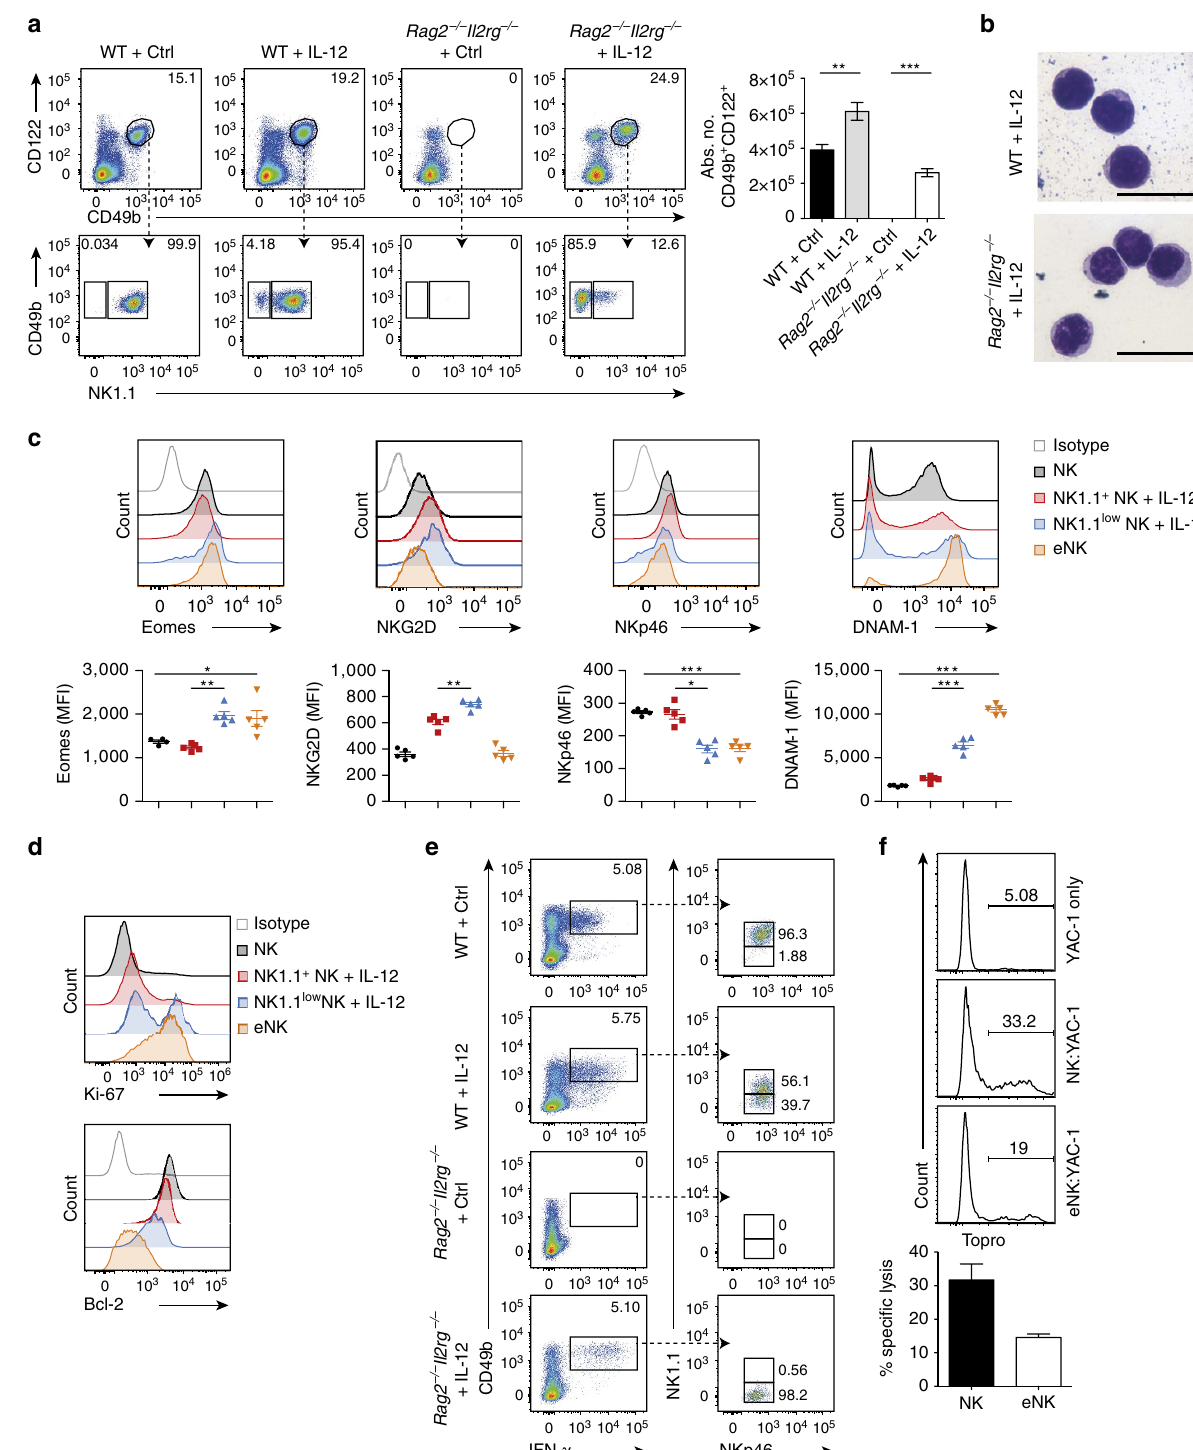
(Fig. 4a–c). Both in WT and Rag2 (cid:2) / (cid:2) Il2rg (cid:2) / (cid:2) mice, IL-12 induced the emergence of eNK cells (DX5 þ NK1.1 (cid:2) NKp46 low CD11b þ CD27 low KLRG1 high cell in cluster 5), and an unexpec- ted population of DX5 low NK1.1 (cid:2) NKp46 (cid:2) CD11b (cid:2) CD27 (cid:2) KLRG1 (cid:2) cells (cluster 4), probably representing an intermediate precursor stage of NK-cell development (Fig. 4a–c). Also in the BM, we observed the expression of Eomes in eNK cells by using an Eomes fluorescent reporter mouse (Supplementary Fig.